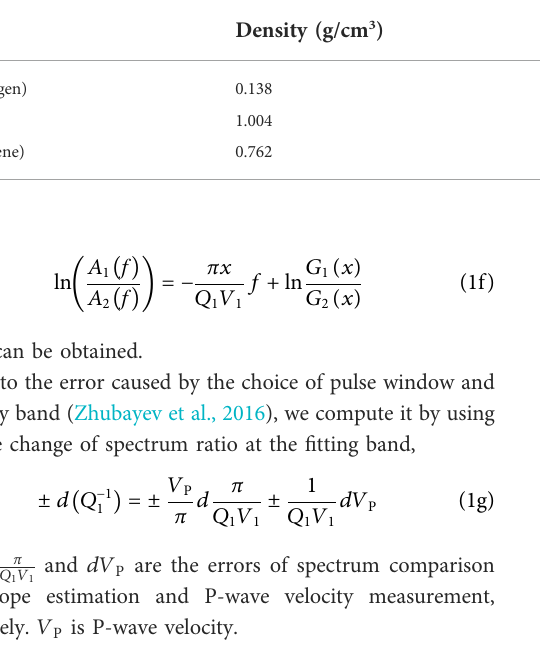
TABLE 3 Fluid properties.